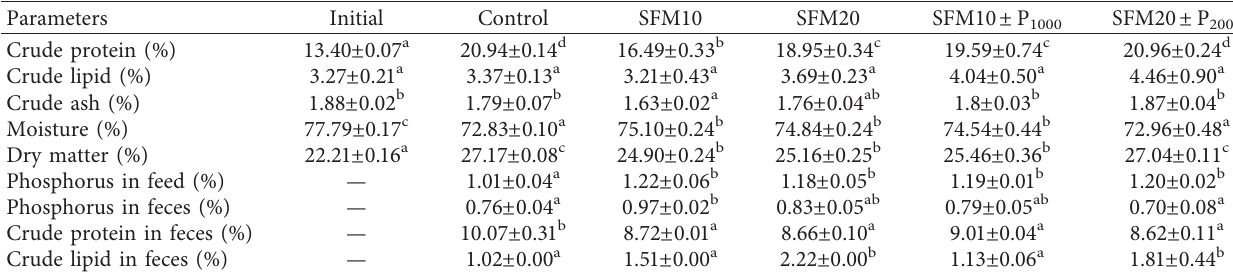
Table 5: Biochemical composition of fish and feces.